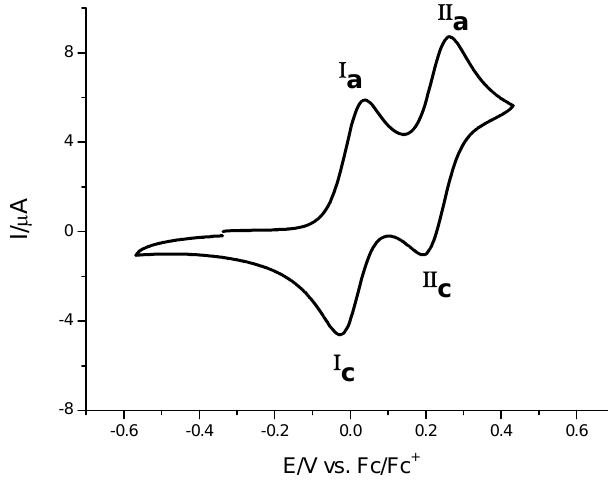
Figure 4. Cyclic voltammograms obtained for 7 in the presence of 0.1 M TBABF acetonitrile. Scan rate 0.5 V s − 1 . The scan potential was initiated from E direction. The working electrode used was a platinum disc.